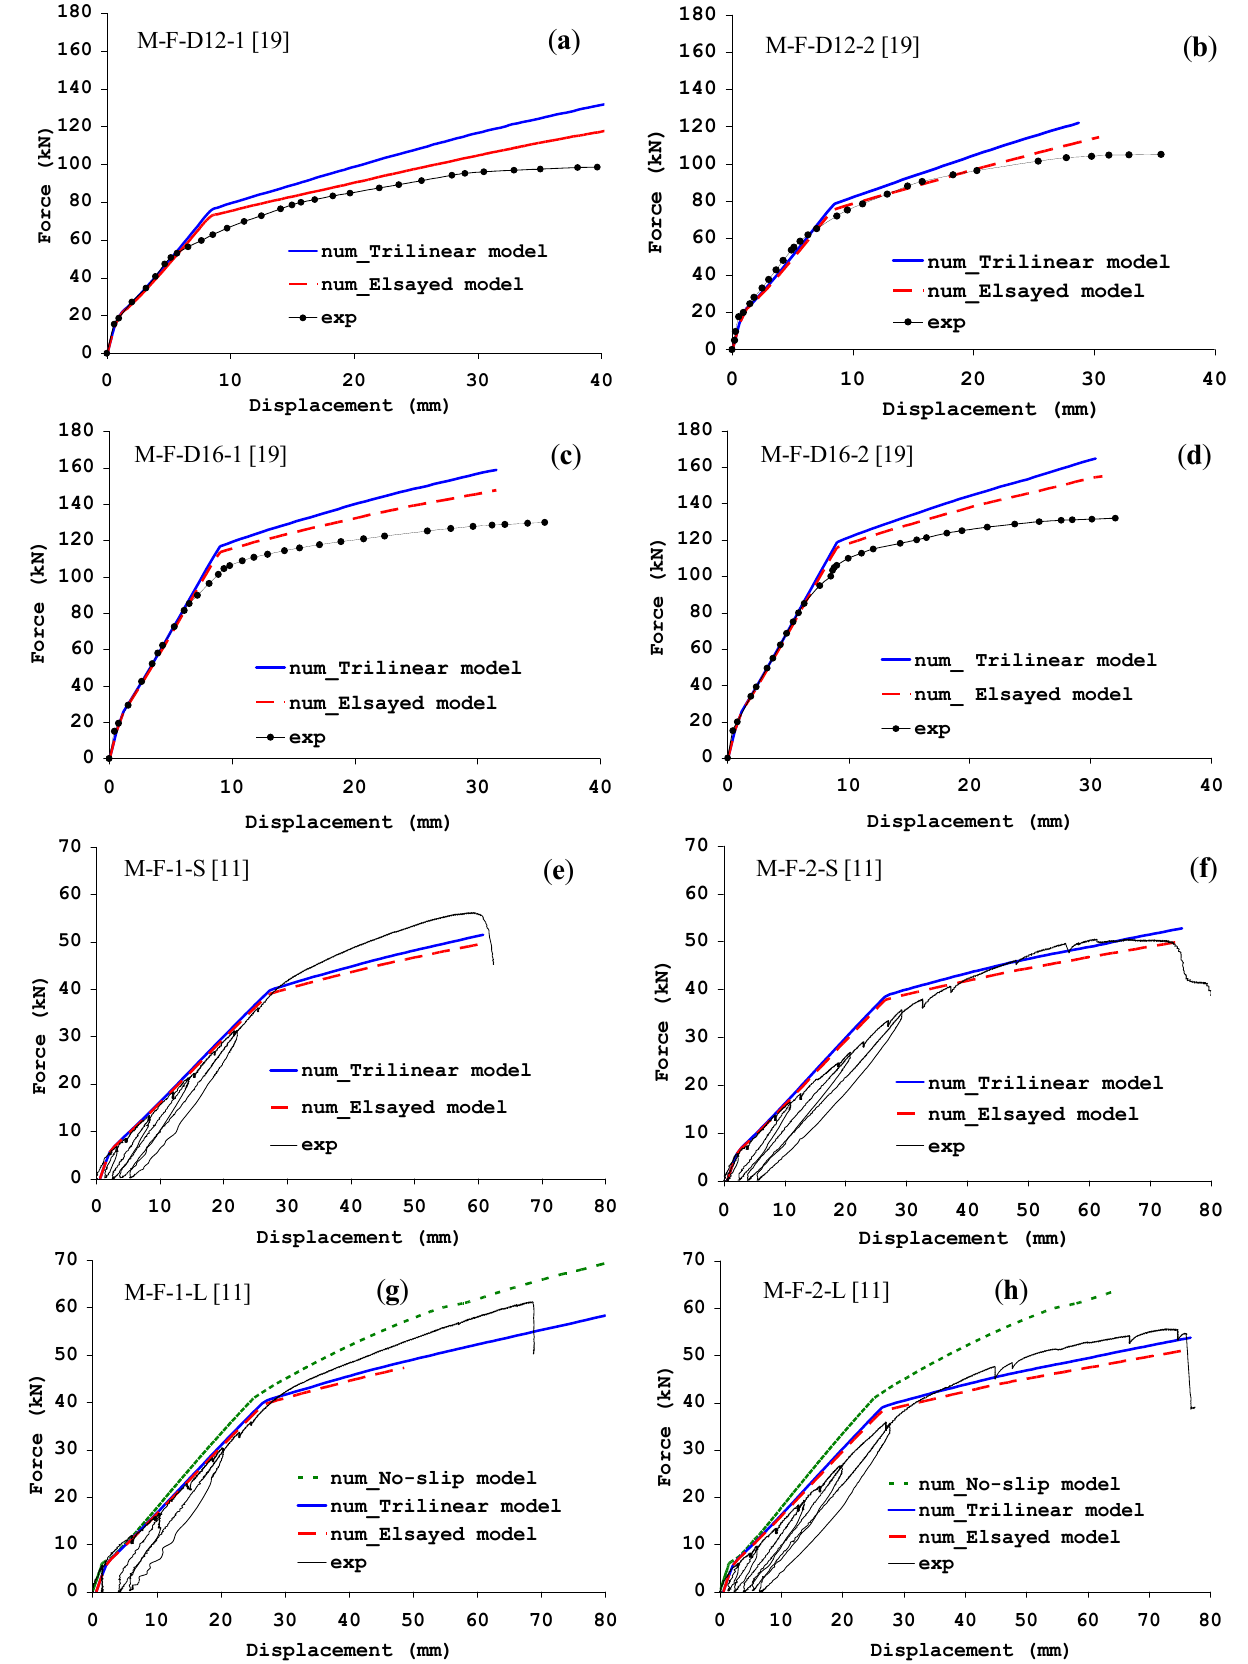
Figure 9. Influence of the bearing stress-slip interface law: numerical simulations of tests by Ebead [19] ( a – d ) and Napoli et al . [11] ( e – h